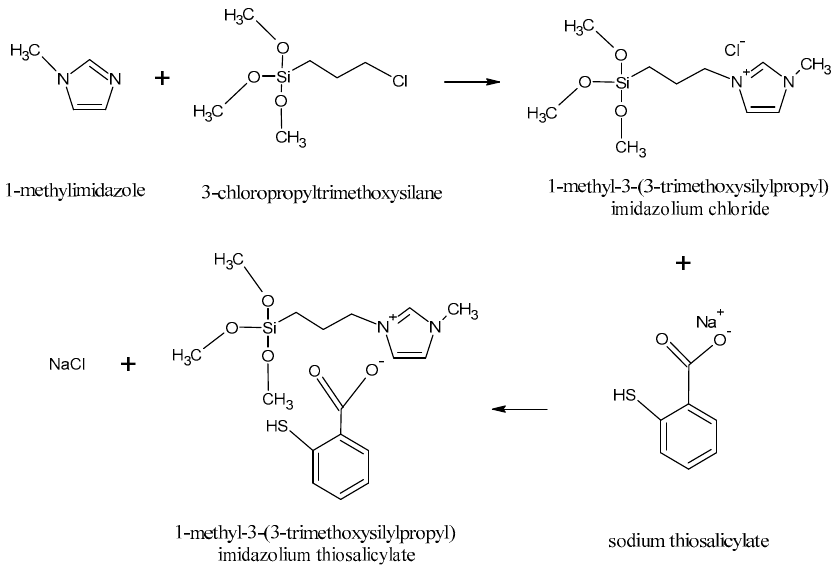
Figure 12. The synthesis route for the formation of [MTMSPI][TS] ionic